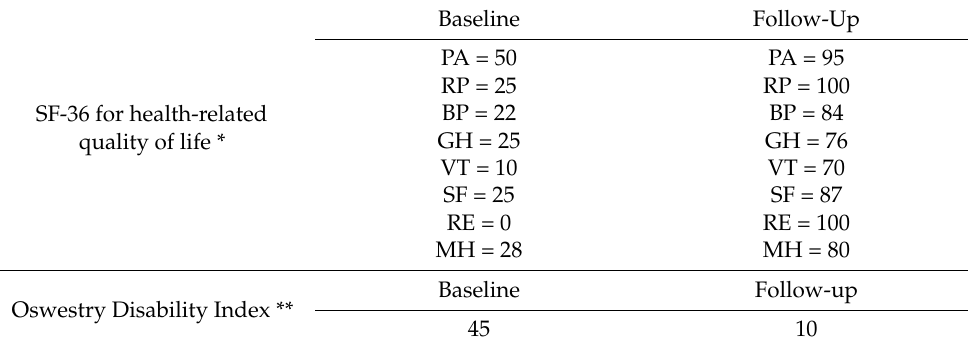
Baseline Follow-up Oswestry Disability Index Baseline